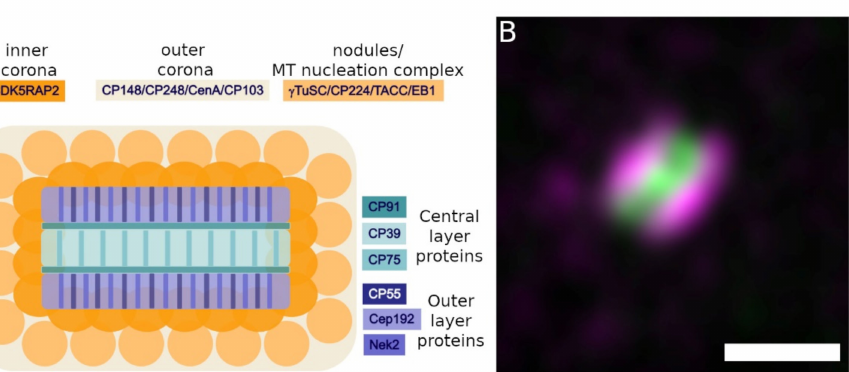
Figure 3. ( A ) Schematic of subcentrosomal distribution of the major centrosome components. The color code given with the protein names refers to the individual centrosomal substructures; ( B ) Ex- pansion microscopy of nanobody-labeled Cep192 (magenta) and CP39 (green). Bar = 0.25 µ